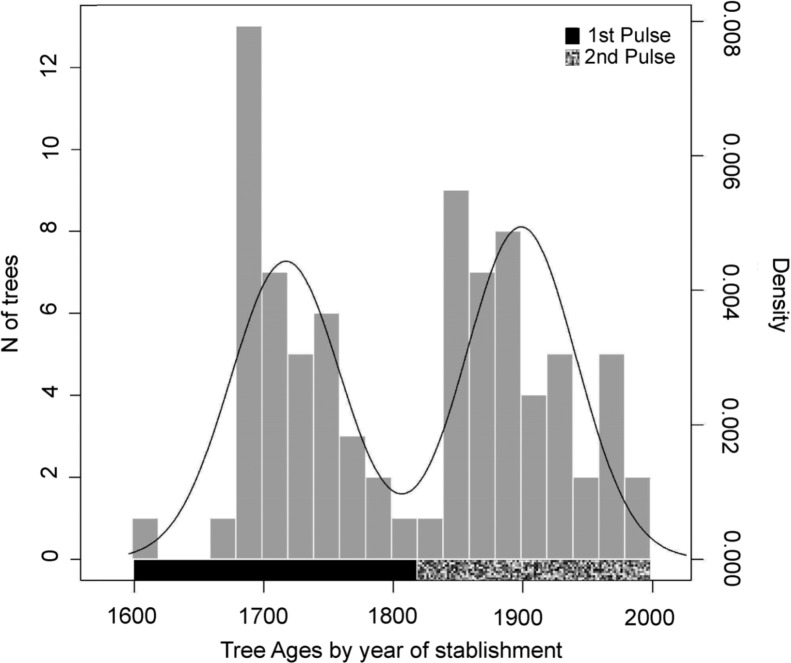
Recruitment histogram with estimated density curve of the Brazil nut stand at Purupuru Lake, Central Amazonia.The black line is a curve of probability density relative to the age distribution estimates based on bootstrap simulations, gray bars are the number of trees in 20-year intervals, the hatched and black bars represent the two clusters we call recruitment pulses.